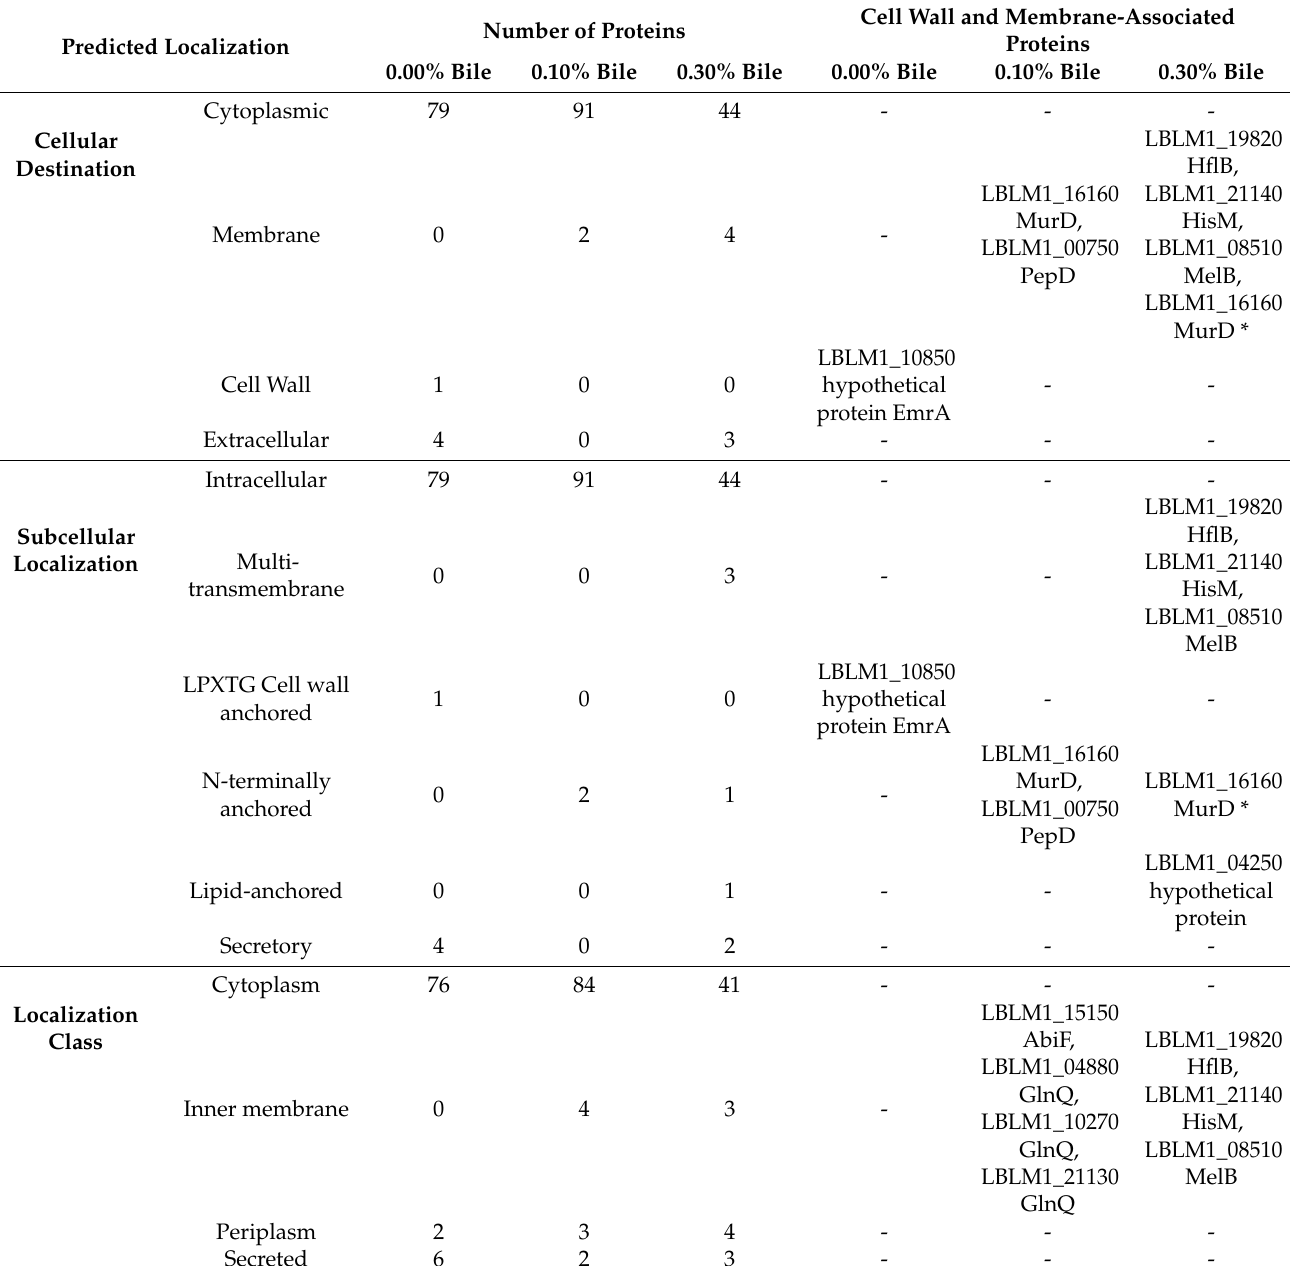
Table 1. Cell wall and membrane-associated proteins with possible bile response roles, extracted from Lactobacillus